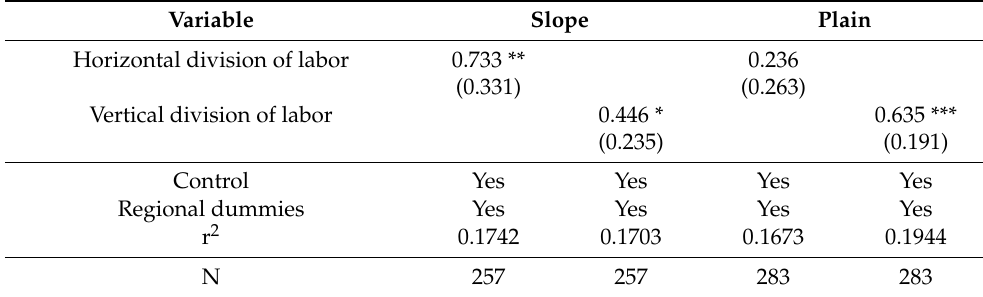
Table 5. Regression results based on grouping in terms of